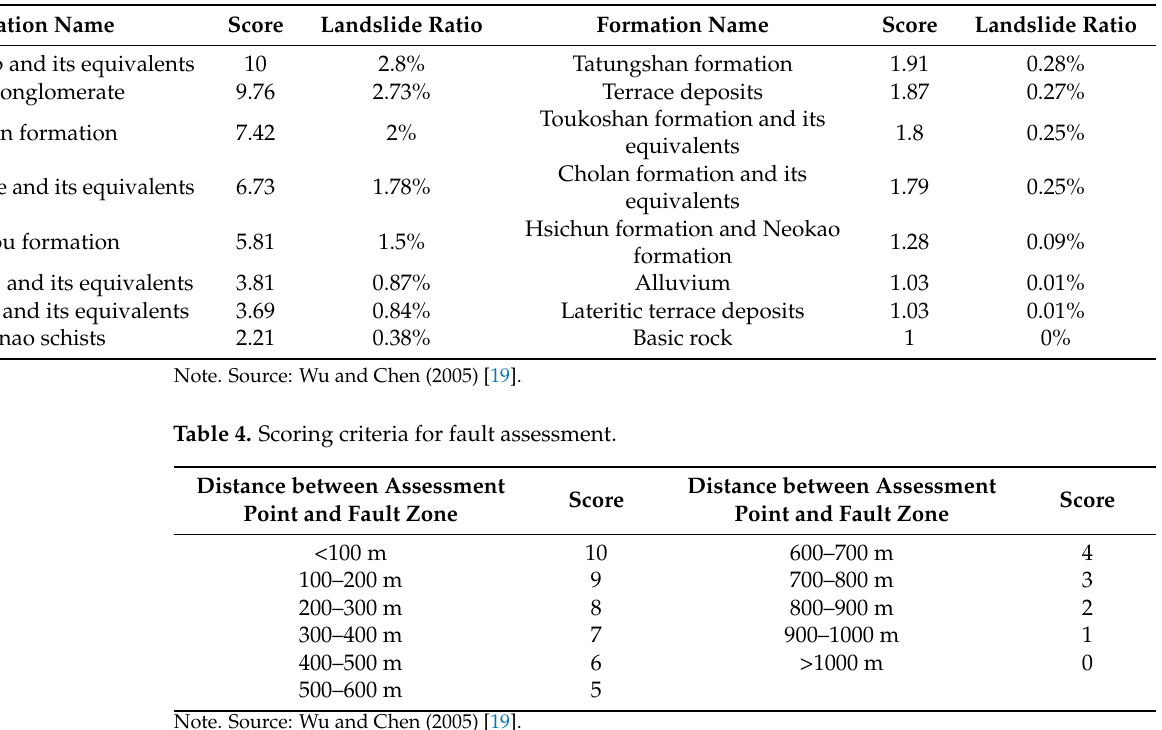
Table 3. Strata scoring criteria.